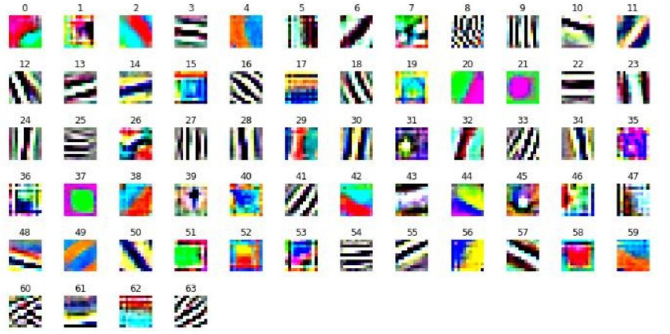
Fig 1. Visualization of first layer convolutional filters of